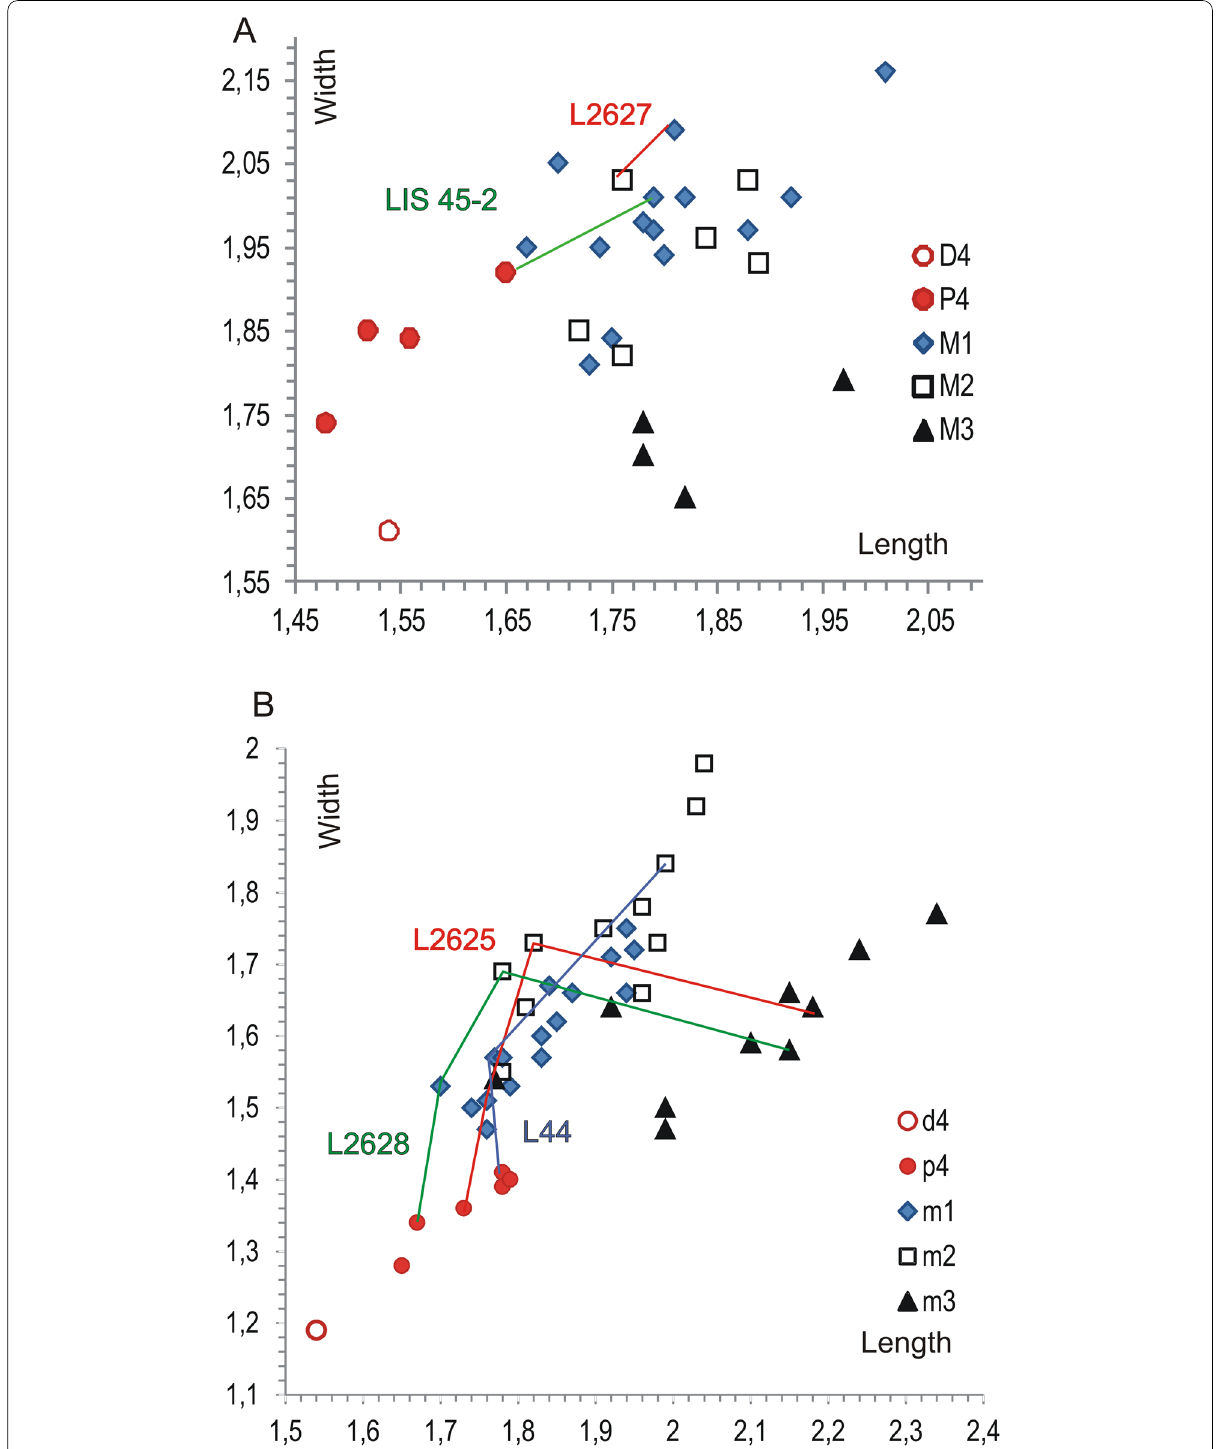
Fig. 13 Bivariate graph of the size (width/length) of the upper (A) and lower (B) teeth of Protadelomys lugdunensis Hartenberger, 1969 from Lissieu (Rhône). The colored lines joins the different loci on a same jaw. A upper teeth. L2627, Holotype, M1–M2, red line; LIS 45–2, P4–M1, green line. B lower teeth. L2625, p4–m3, red line; L2628, p4–m3, green line; L44, p4–m2, blue